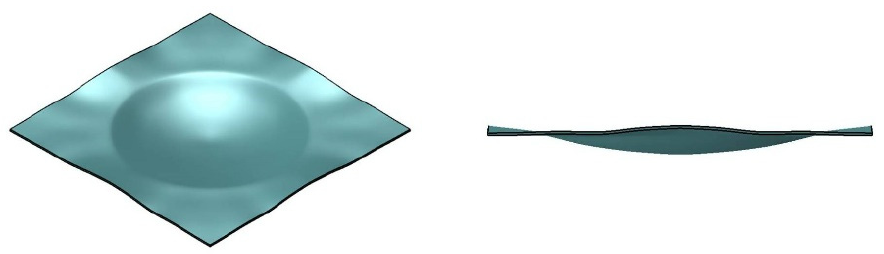
Figure 16. Deformation of the monolithic reference plate under blast loading (t = 0.6 ms).